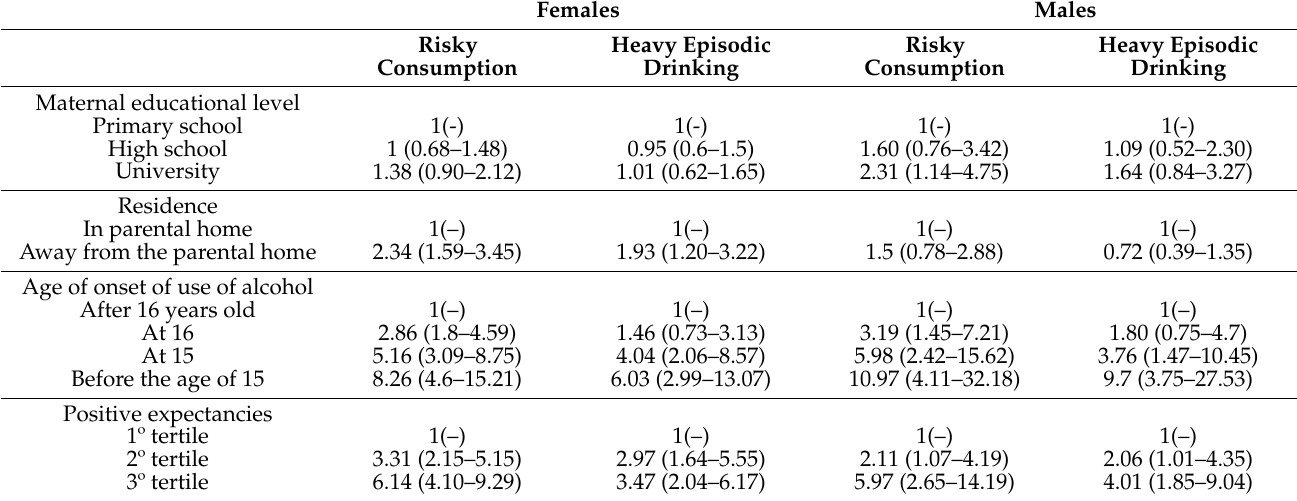
Table 3. Influence of explanatory factors on Risky consumption and Heavy episodic drinking among male and female students in 2005. Results are presented as adjusted odds ratio (95%CI) a .